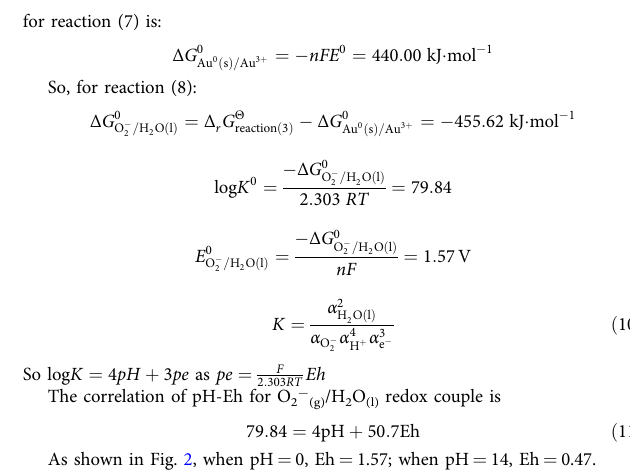
Fig. 7 The conceptual model for mycological gold redox transformation under Earth surface conditions. Superoxides from fungal hyphae oxidatively dissolve colloidal gold to gold ions with likely assistance of protons. Gold ions then complex with the intracellularly produced ligand. Colloidal gold nanoparticles may be regenerated from the interaction between gold complexes and reduced organic carbon species. Dashed arrows indicate superoxides and ligands are produced